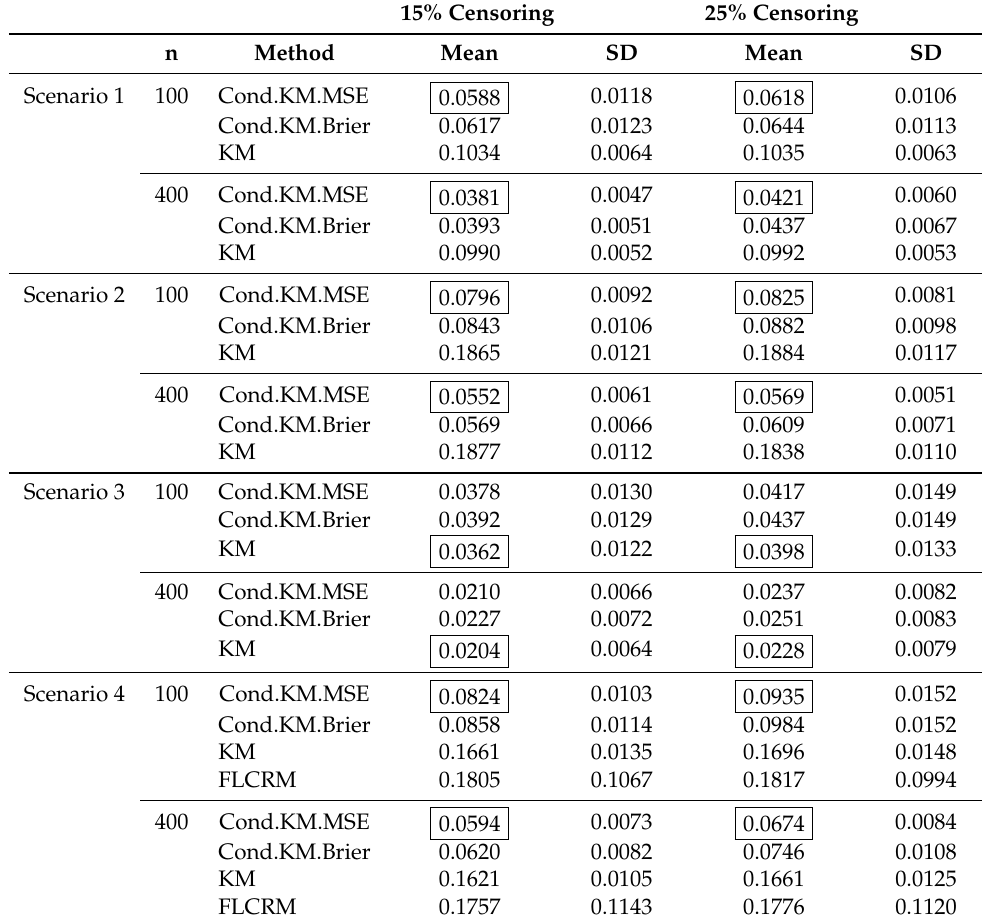
Table 1. The MSPEs of the survival probability in the test data using conditional functional KM, regular KM, and FLCRM under different